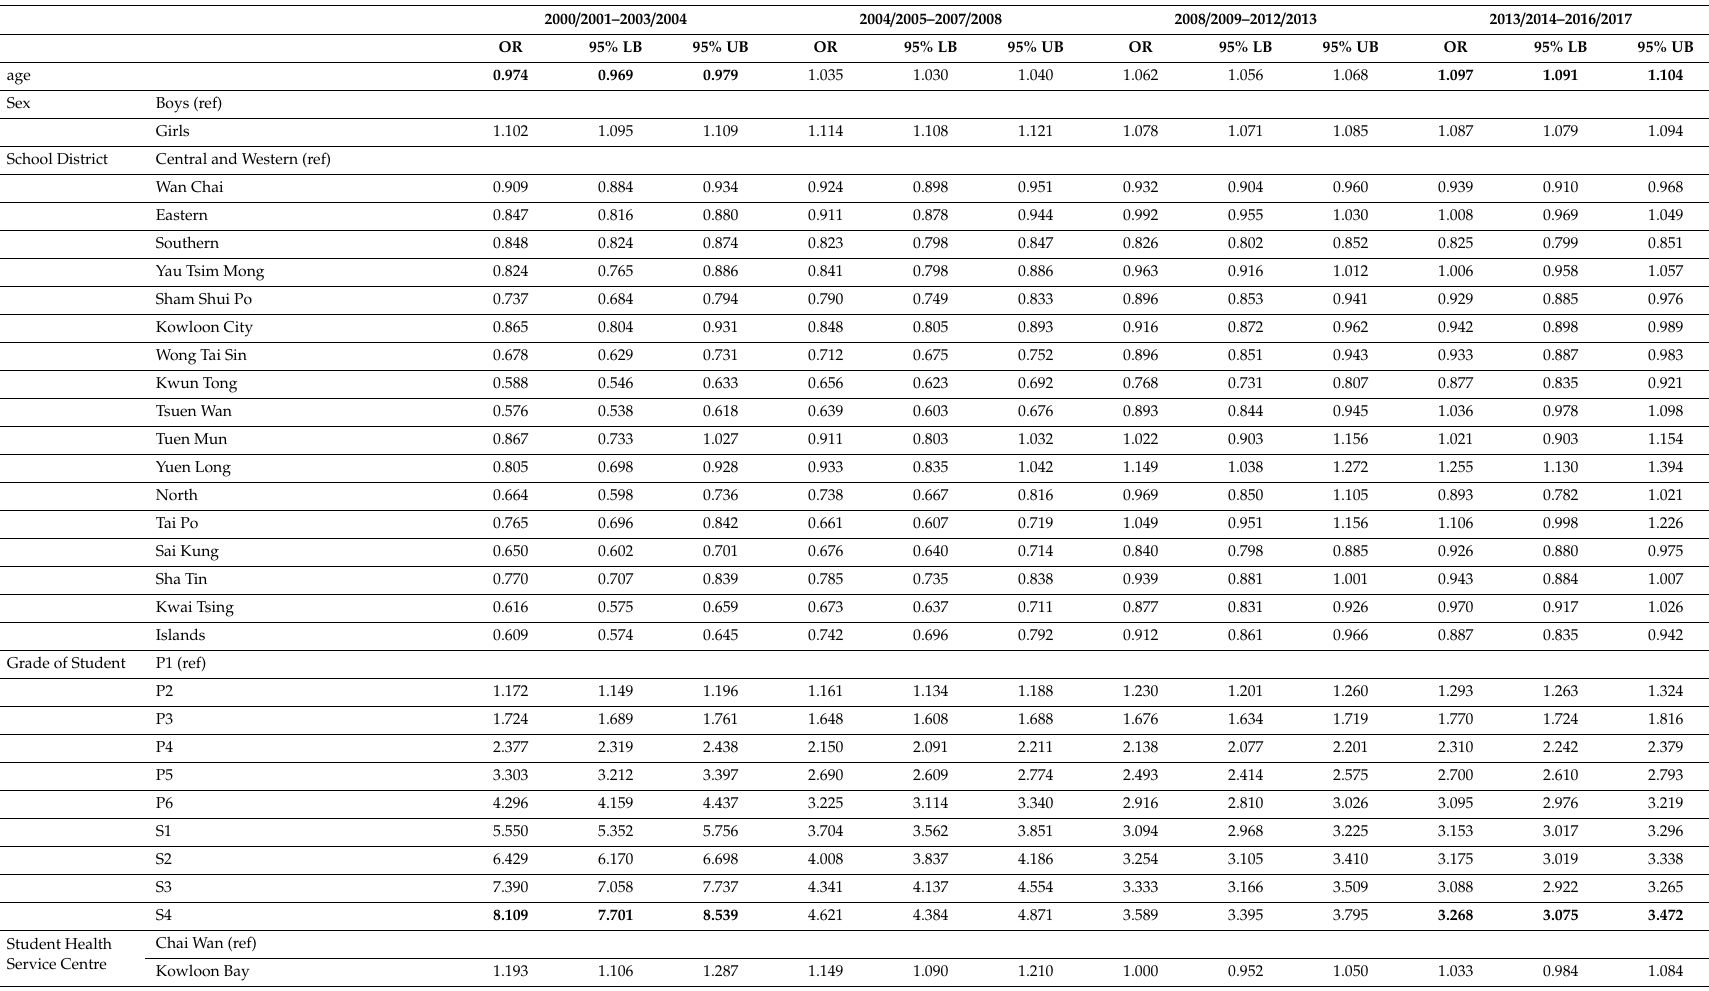
Table 3. Factors associated with reduced visual acuity in the schoolchildren of Hong Kong during 2000 / 2001 − 2003 / 2004, 2004 / 2005 − 2007 / 2008, 2008 / 2009 − 2012 / 2013 and 2013 / 2014 − 2016 / 2017: Multivariate logistic